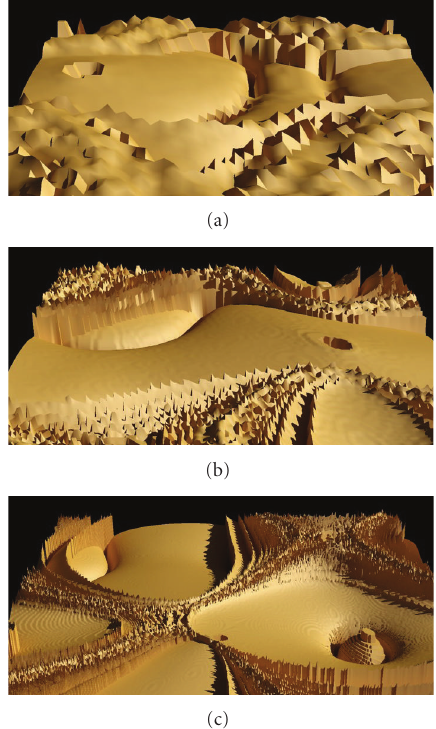
Figure 12: Exotic terrain generated by TP in (4), with resolutions 50 × 50, 150 × 150, and 450 × 450.